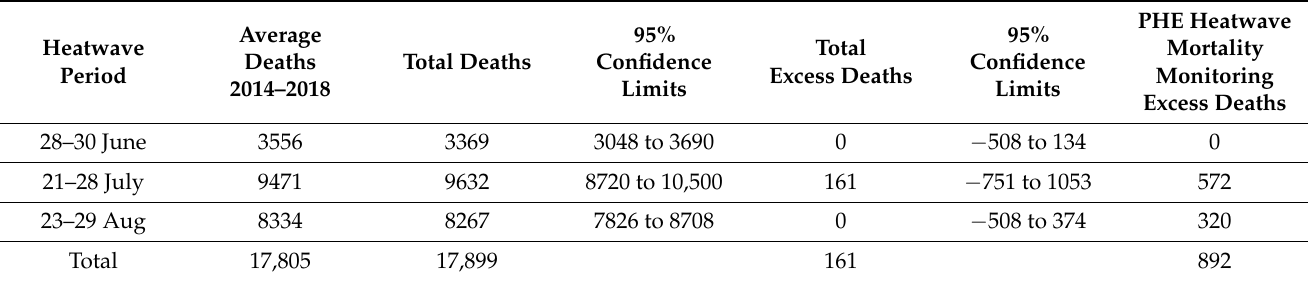
Figure 2. Comparison of observed and expected daily mortality in England in Summer 2019 relative to the mean Central England Temperature (CET). The daily number of deaths (green line) and 7-day moving average were compared to the expected number (black line) with the daily maximum CET (°C, brown line) and daily mean CET (°C, purple line) during the summer period of 2019. The shaded blue area highlights periods which met the PHE heatwave criteria as defined in Green et al. 2016. Table 1. Summer 2019 heatwave periods, the corresponding 5-year average of death occurrence for the same period and the excess number of deaths with 95% confidence intervals.